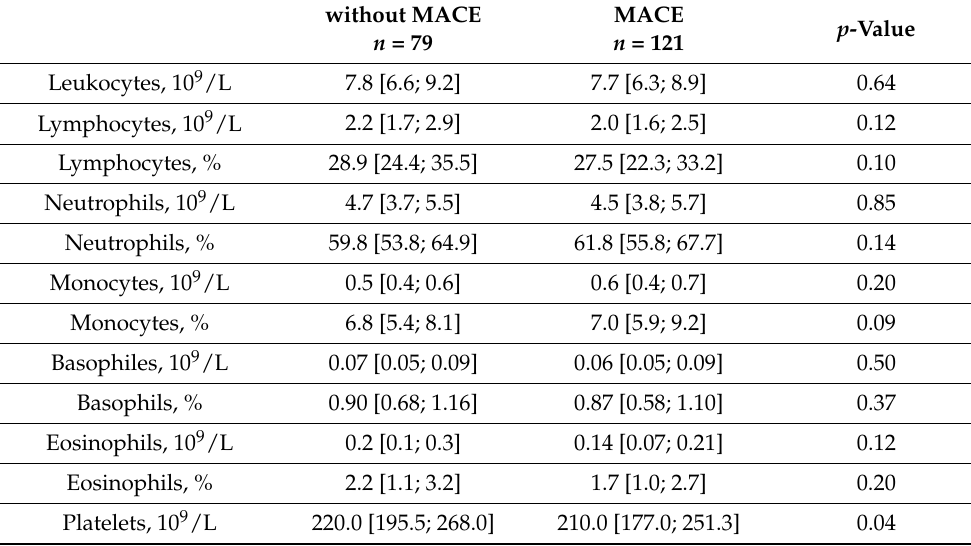
Figure 2. The proportion of patients with Lp (a) ≥ 30 mg/dL in groups with and without MACE. A trend towards a more rapid development of MACE was detected in the patients with Lp(a) ≥ 30 mg/dL. The patients without MACE but with Lp(a) ≥ 30 mg/dL had a mean survival time of 143 ± 15 months versus 168 ± 18 months in those with Lp(a) < 30 mg/dL, p < 0.01 (Figure A2). The blood-cells count did not significantly differ in the patients with and without MACE (Table 2). Table 2. Blood cells counts in patients with and without MACE.